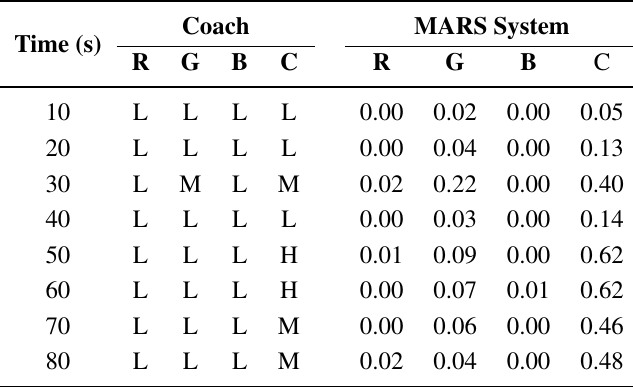
Table 4. Session B , coach and system assessment.